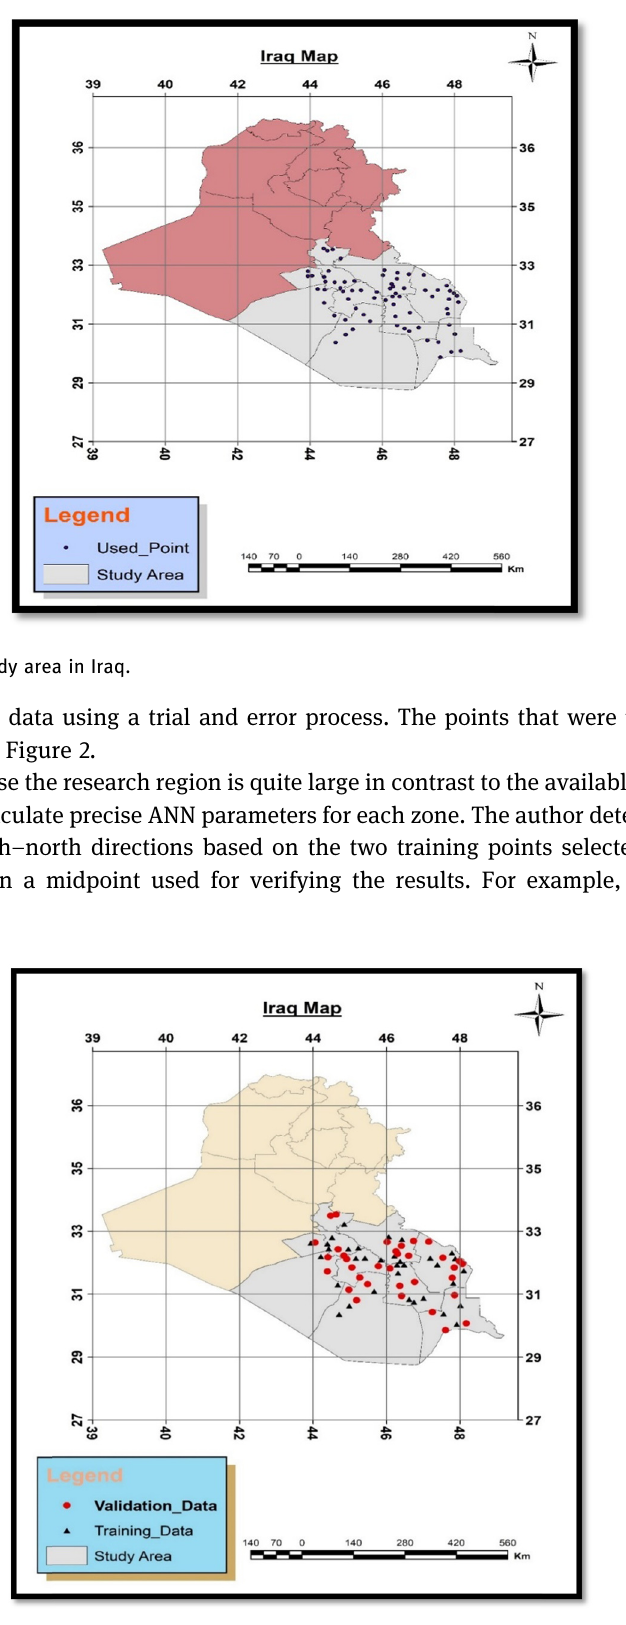
Figure 2: Training and validation data in the study